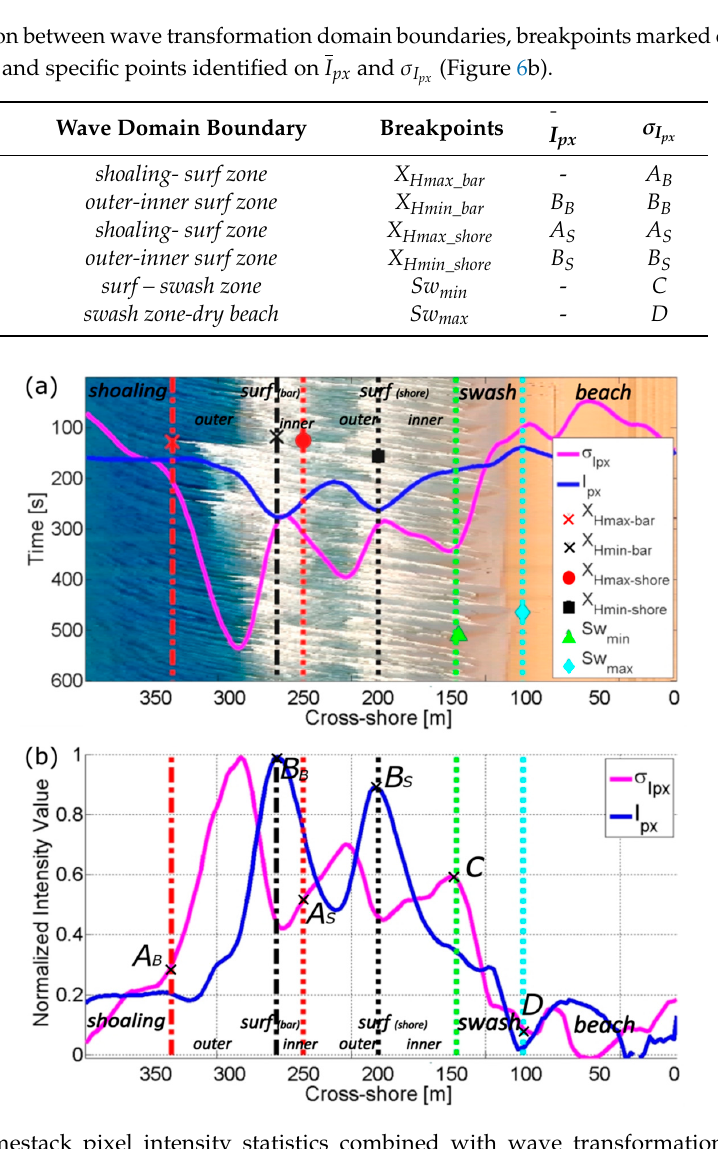
Figure 6. Timestack pixel intensity statistics combined with wave transformation domains at Tarquinio-Paraiso. ( a ) Wave transformation domains superimposed on Timestack combined with I px and σ I . Dashed colored lines identify the boundaries between wave domains. ( b ) Min–Max I px (blue line) and σ I (magenta line) plotted together with wave transformation regions boundaries. The specific points on signal which coincide with wave domain boundaries are indicated with related name and by black crosses (see also Table 2). Dashed colored lines identify the boundaries between wave domains.